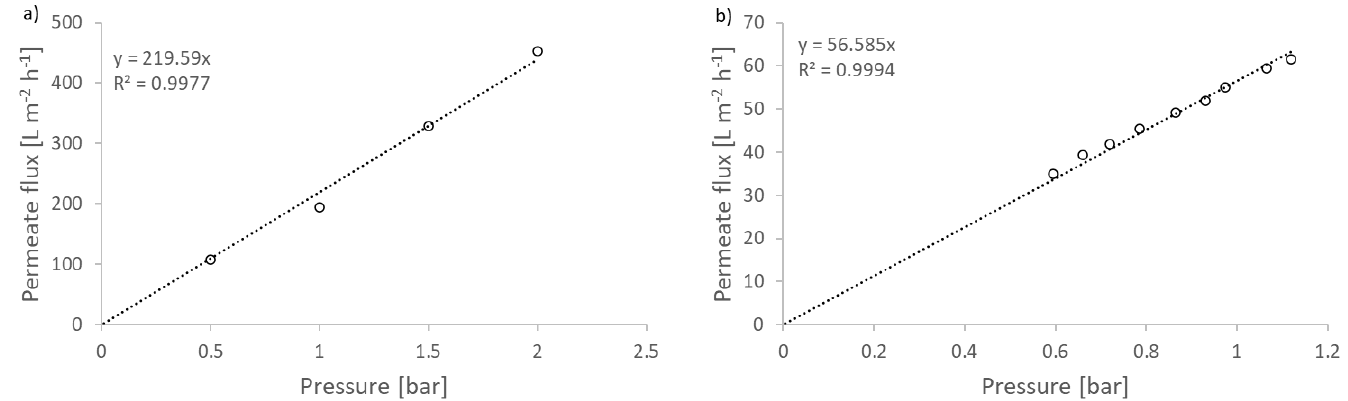
Figure 3. Clean water flux comparison for the two membranes used in this study. ( a ) The PSUH Nadir US100 membrane, used in the frontal (dead-end) filtration experiments; and ( b ) the PVDF KOCH ABCOR ® tubular membrane system.